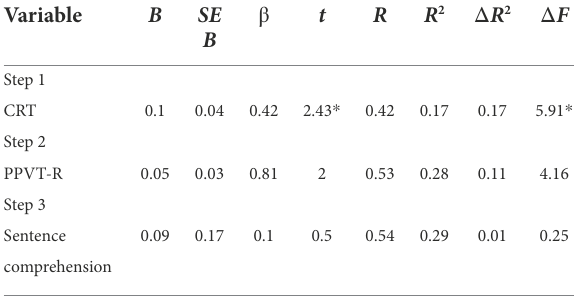
TABLE 6 Regression analysis results of nonverbal FB for the TD